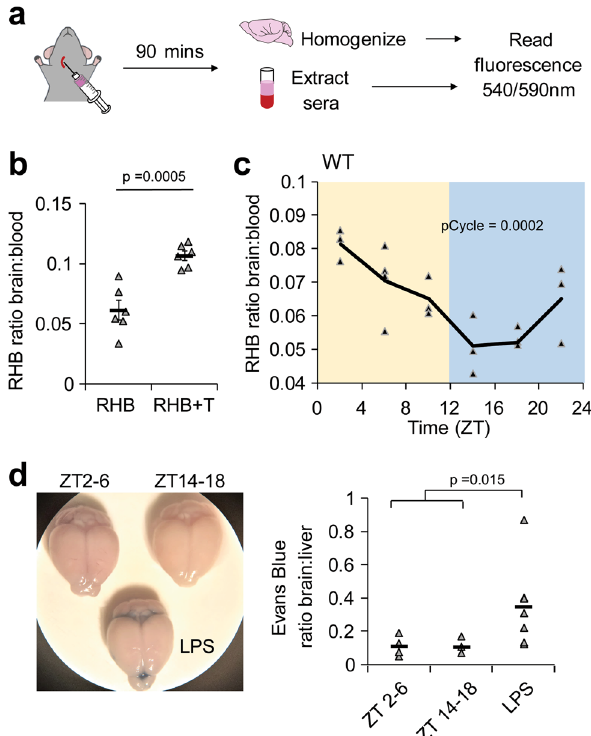
Fig. 1 Ef fl ux of ABCB1 substrate from the brain oscillates over the course of the day. a Schematic of experiment. The ABCB1 substrate RHB was intravenously injected via jugular vein into mice. Mice were allowed 90 min to recover and brains and sera were collected. Fluorescence was read at ex540/em590nm using a plate reader. b Brain RHB levels are regulated by ABCB1-mediated ef fl ux. RHB or RHB and the ABCB1-inhibitor tariquidar was intravenously injected into WT mice. Individual mice are shown with triangle markers and means ± SEM are shown ( n = 6; 2 independent experiments). c RHB injection was performed on WT mice at indicated time points. Individual points are shown with triangle markers and lines represent the mean. pCycle value was calculated by JTKCycle analysis ( n =